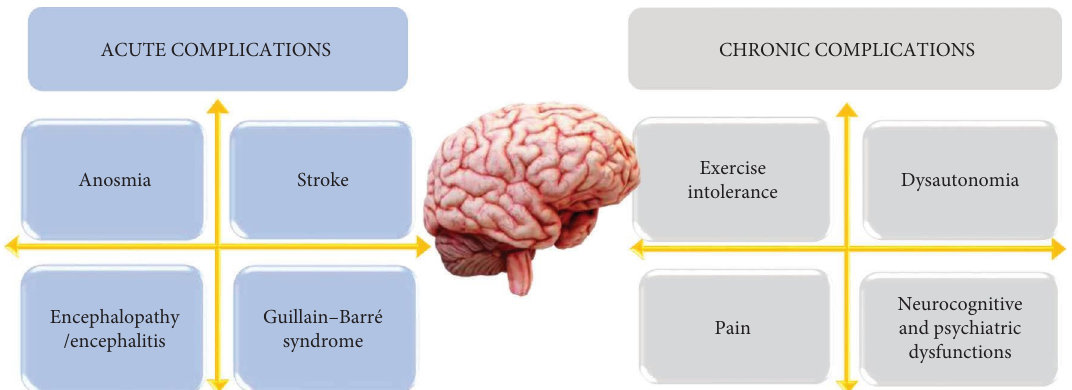
Figure 6: Acute/chronic complications in neurological disease related to